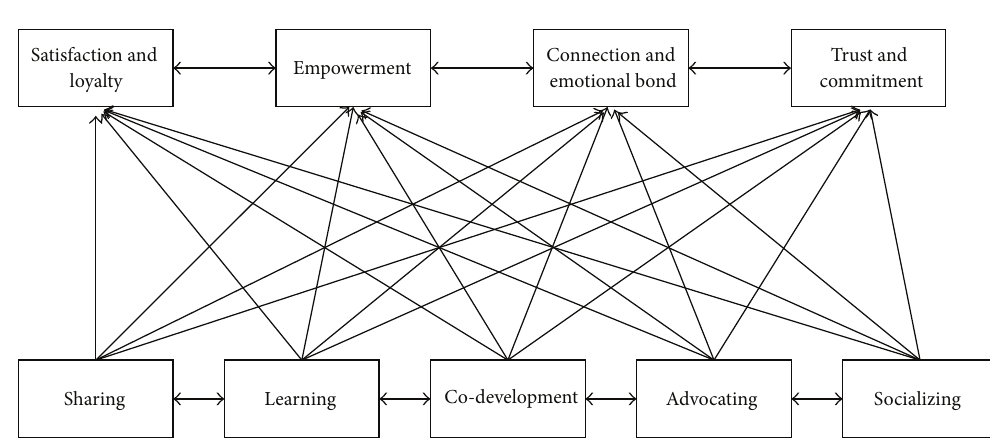
Figure 9: Two levels of structural model of model